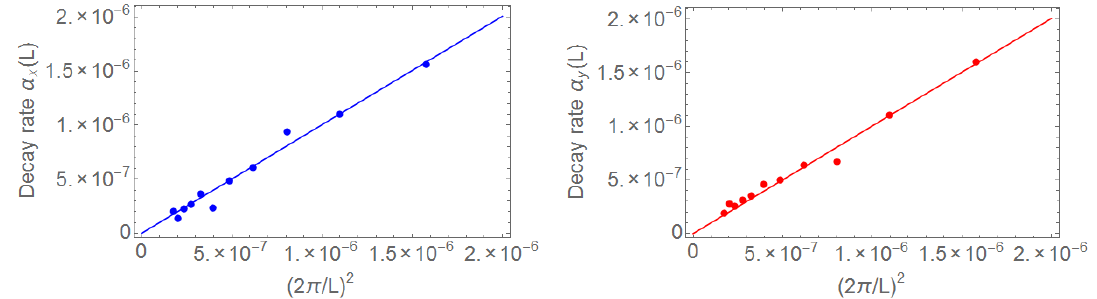
Figure 8 . The k-space plot of the velocity (cid:12)eld (left) and the energy density (right) at the (cid:12)nal phase of the two dimensional turbulent (cid:13)ow ( t = 960 (cid:28) ) from (cid:12)gure 1. One can notice that the velocity (cid:12)eld is dominated by the lowest transverse modes as shown in (5.6), while the energy density is dominated completely by the zero mode ( (cid:15) (cid:24) E 0 ).